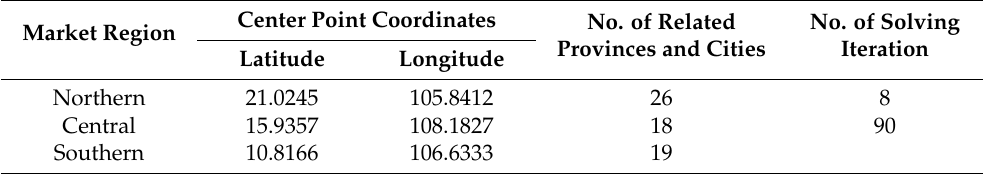
Table 5. Market region center point